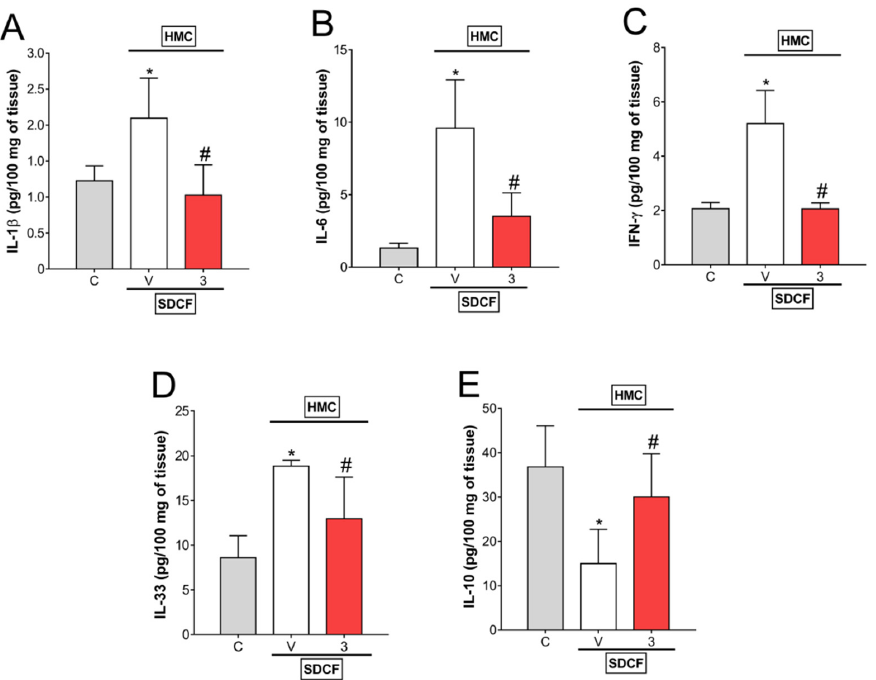
Figure 5. HMC inhibits SDCF-induced IL-1 β , IL-6, IFN- γ , and IL-33, and reverses SDCF-induced depletion of IL-10 levels in renal tissue. Kidney was collected 24 h after the administration of SDCF for the evaluation of IL-1 β ( A ), IL-6 ( B ), IFN- γ ( C ), IL-33 ( D ), and IL-10 ( E ) levels. Results are ex- pressed as mean ± SD, n = 6 mice per group per experiment, and are representative of two inde- pendent experiments. * p < 0.05 vs. control (C) group; # p < 0.05 vs. vehicle (V) treated group; one ANOVA followed by Tukey’s post hoc test.